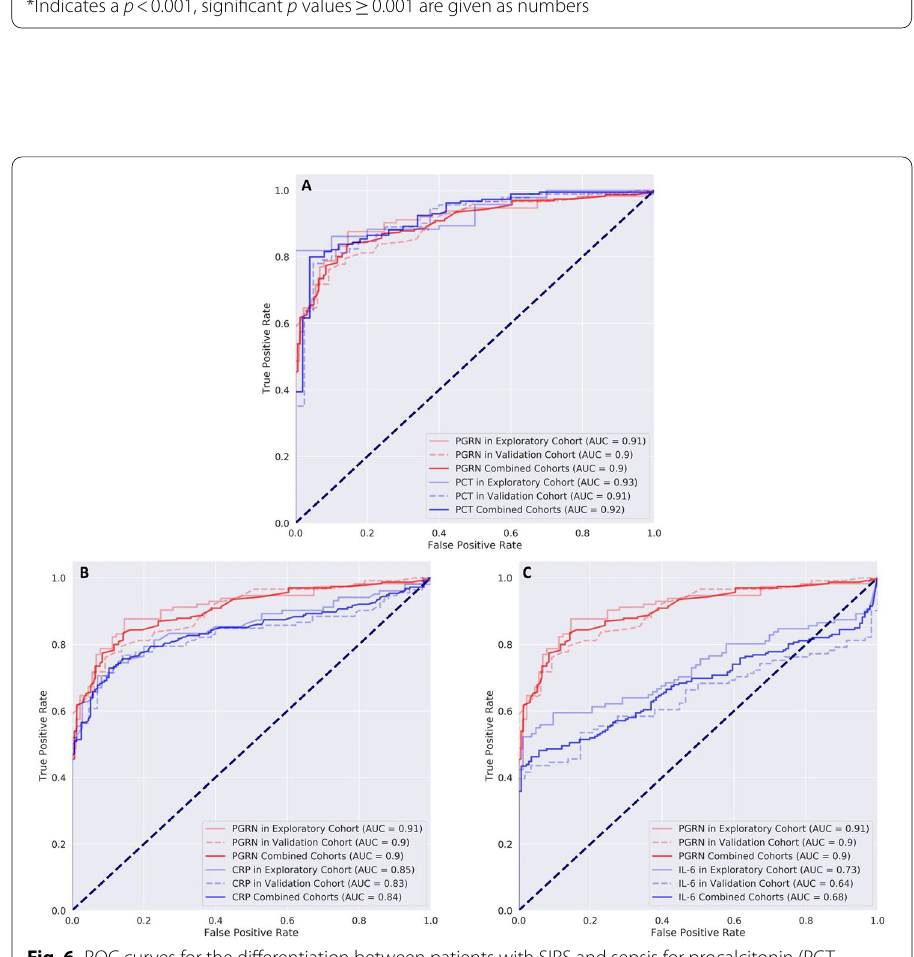
Fig. 6 ROC curves for the differentiation between patients with SIRS and sepsis for procalcitonin (PCT, A ), C‑reactive protein (CRP, B ) and interleukin‑6 (IL‑6, C ) in comparison to progranulin. Patients with sepsis and septic shock were combined for this analysis. The curves for progranulin are printed in red and the respective lines of the compared reference marker are outlined in blue. Lines printed in lighter colors represent measurements in the exploratory cohort and dashed lines the corresponding measurements in the confirmatory (validation) sample. Dark lines show the summary values from both samples. See text for AUC values and statistical comparison and Additional file 1: Tables S8 and S9 for further